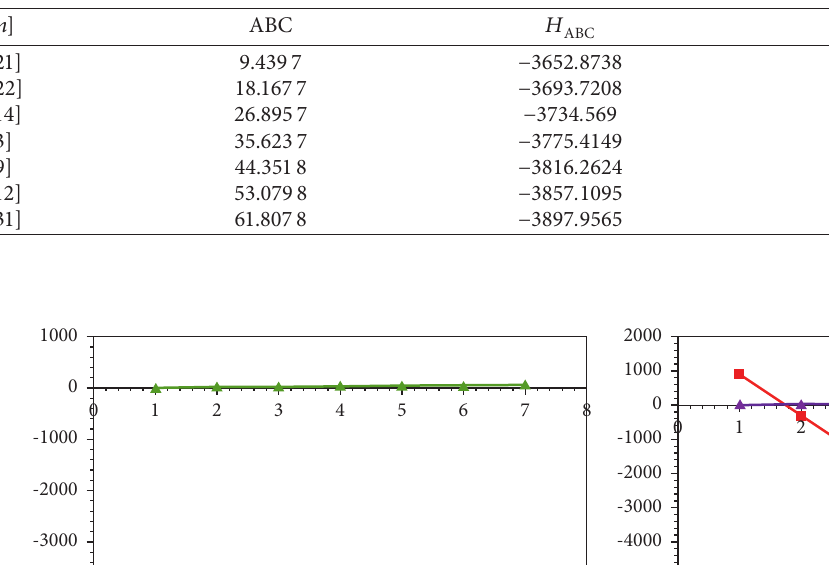
Table 5: Comparison of ABC index and GA index with their respective heat of formation for GST − SL [ n ] .